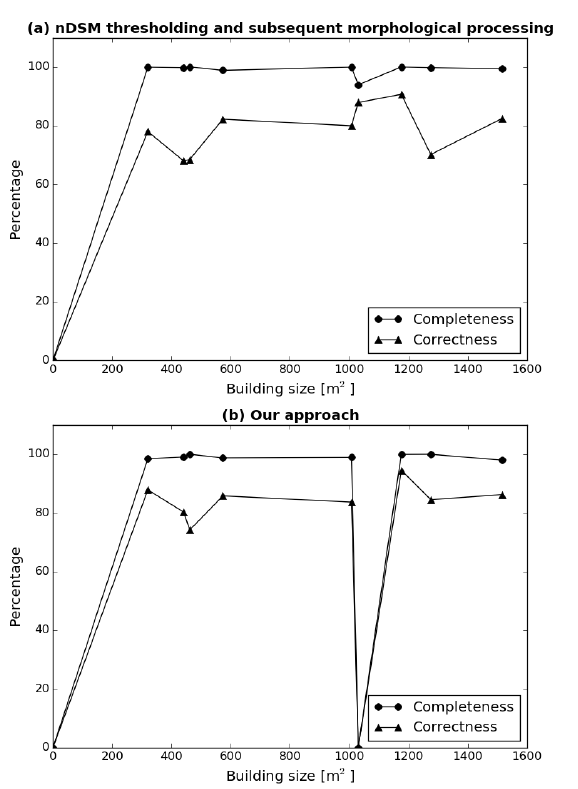
Figure 8: Completeness and correctness of both methods for in- dividual buildings